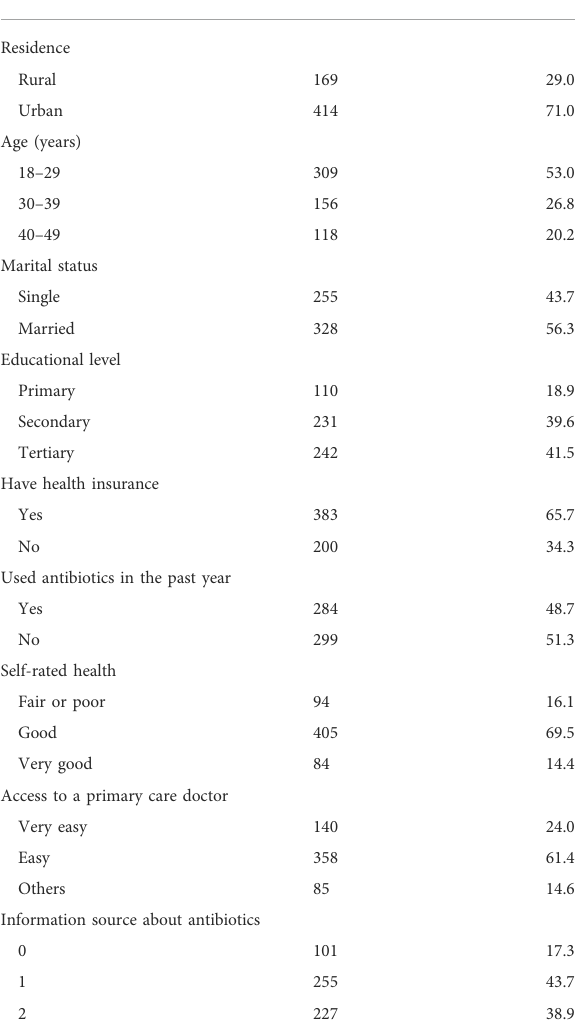
TABLE 1 Characteristics of the study population ( n =